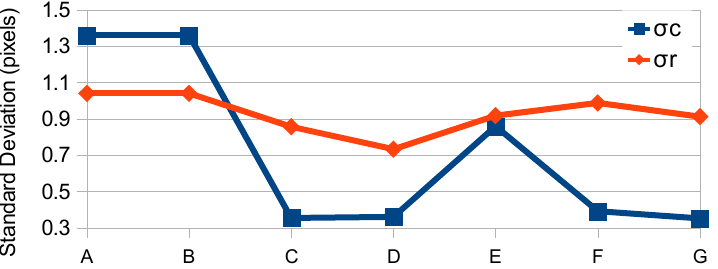
Figure 9. Average values for the standard deviations of discrepancies in tie points coordinates of 5 rectified image pairs with different sets of Interior Orientation Parameters (IOP) and Relative Orientation Parameters (ROP).